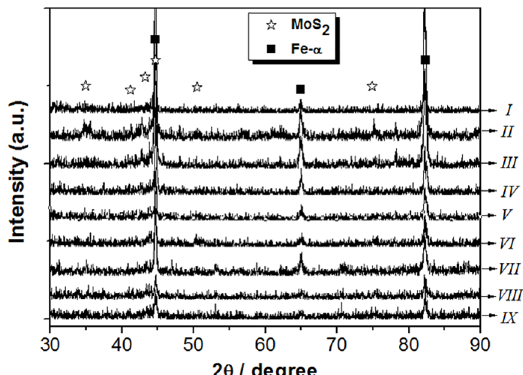
Cr Nb B (at%) + 60 8 8 24